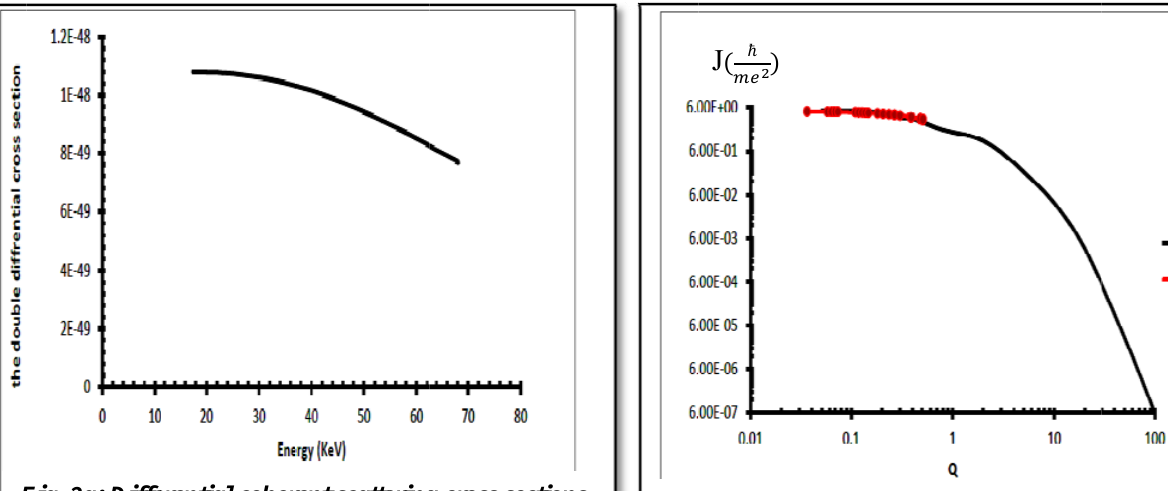
Fig. 2a: Diffe erential coher versus photon